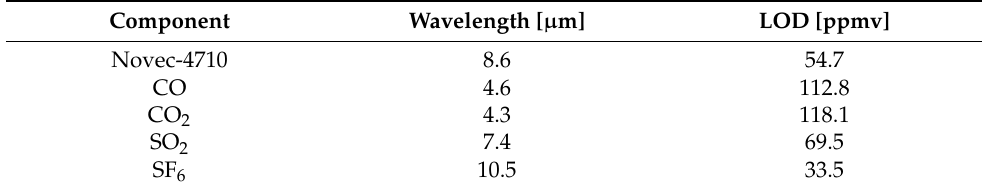
Figure 5. Transmittance according to concentration. The correlations between gas concentration and transmittance were verified at an OPL of ( a ) 5 cm and ( b – f ) 10.5 m. ( a ) The transmittance measured after injecting 3~7% of Novec-4710 into the SP cell with an OPL of 5 cm at 100 Torr. The transmittance measurement data were fitted by the exponential decay function based on the concentration and matched with R 2 = 0.999. ( b – f ) The transmittance measured after injecting several dozen to several thousand ppmv of mixed gas with N 2 as the background gas into the MP cell with an OPL of 10.5 m at 100 Torr. The measured components are ( b ) Novec-4710, ( c ) CO, ( d ) CO 2 , ( e ) SO 2 , and ( f ) SF 6 . For fitting, an exponential decay function was used for Novec-4710 and SO 2 , a linear function was used for CO, and a sigmoidal function was used for CO 2 . For SF 6 , the measurement points were connected by splining. Table 2. Limit of detection (LOD) of each component in the optical configuration with an OPL of 10.5 m. The measurement wavelength of LOD was set to vary based on the molecular properties. The sensitivity of the detector varied based on the measurement wavelength, and the LOD was affected by the detector